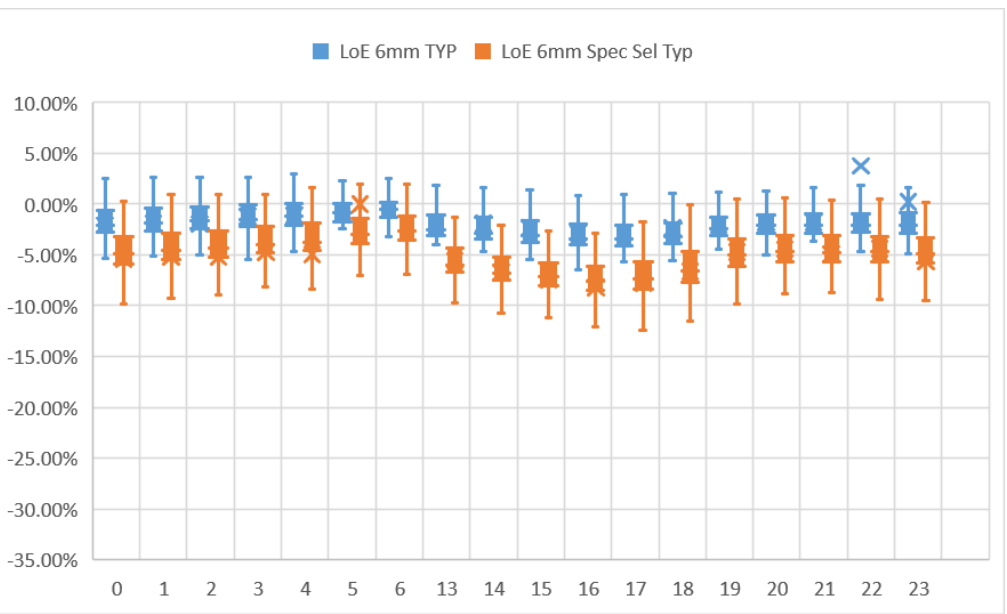
( a ) Box charts for hourly percentage difference in a year for tests for Typical Floor, (1) PCM; (2) 100 mm Internal Insulation; (3) 250 mm Internal Insulation; (4) 500 mm Internal Insulation.